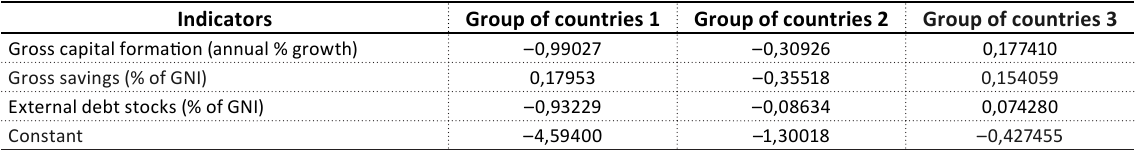
Table 3. Classification of discriminant models